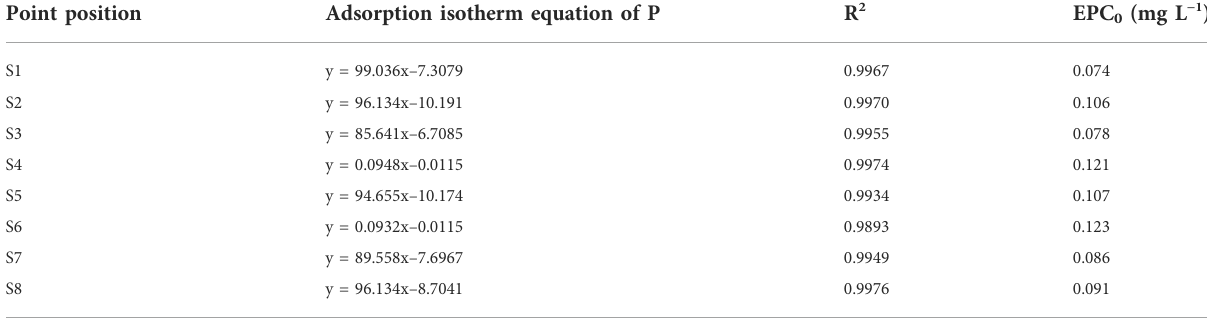
TABLE 2 P adsorption isotherm equation and the EPC 0 value of sediments in the Xishan Reservoir. Point